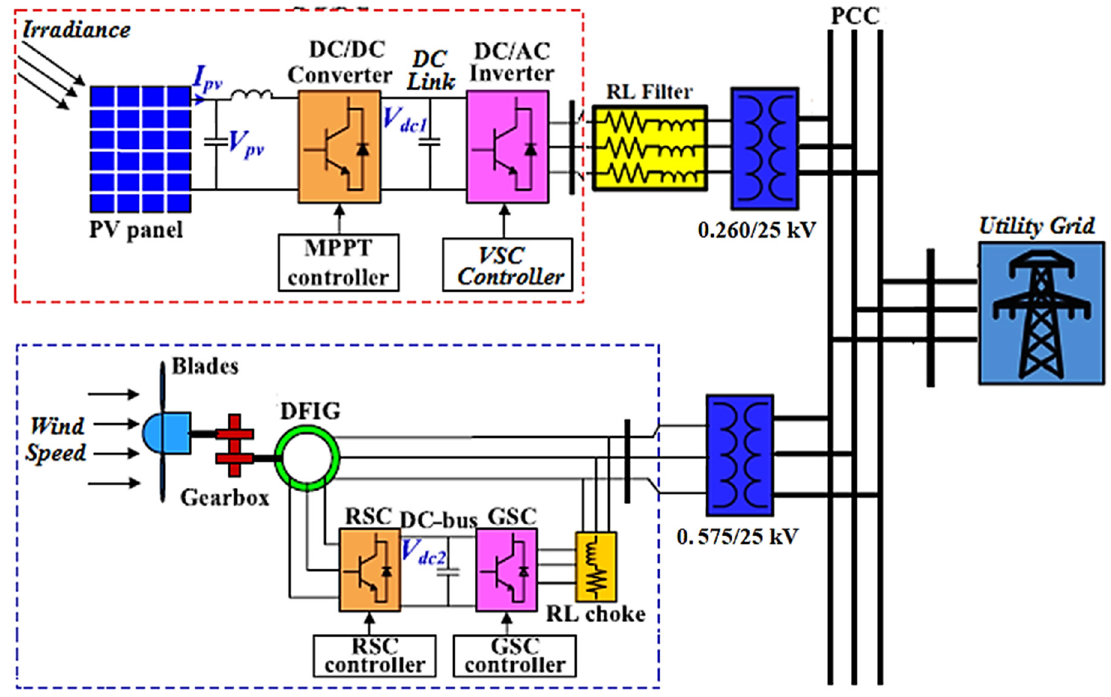
Figure 1. Schematic representing a model of a PV/wind test system connected to a grid.